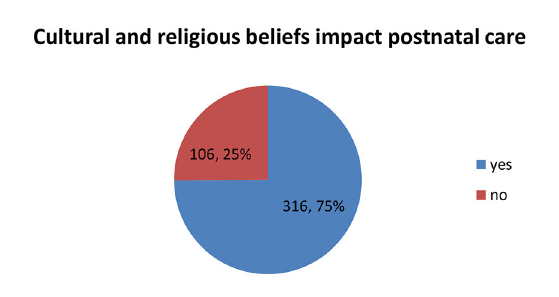
FIGURE2 Cultural and religious practices impact postnatal